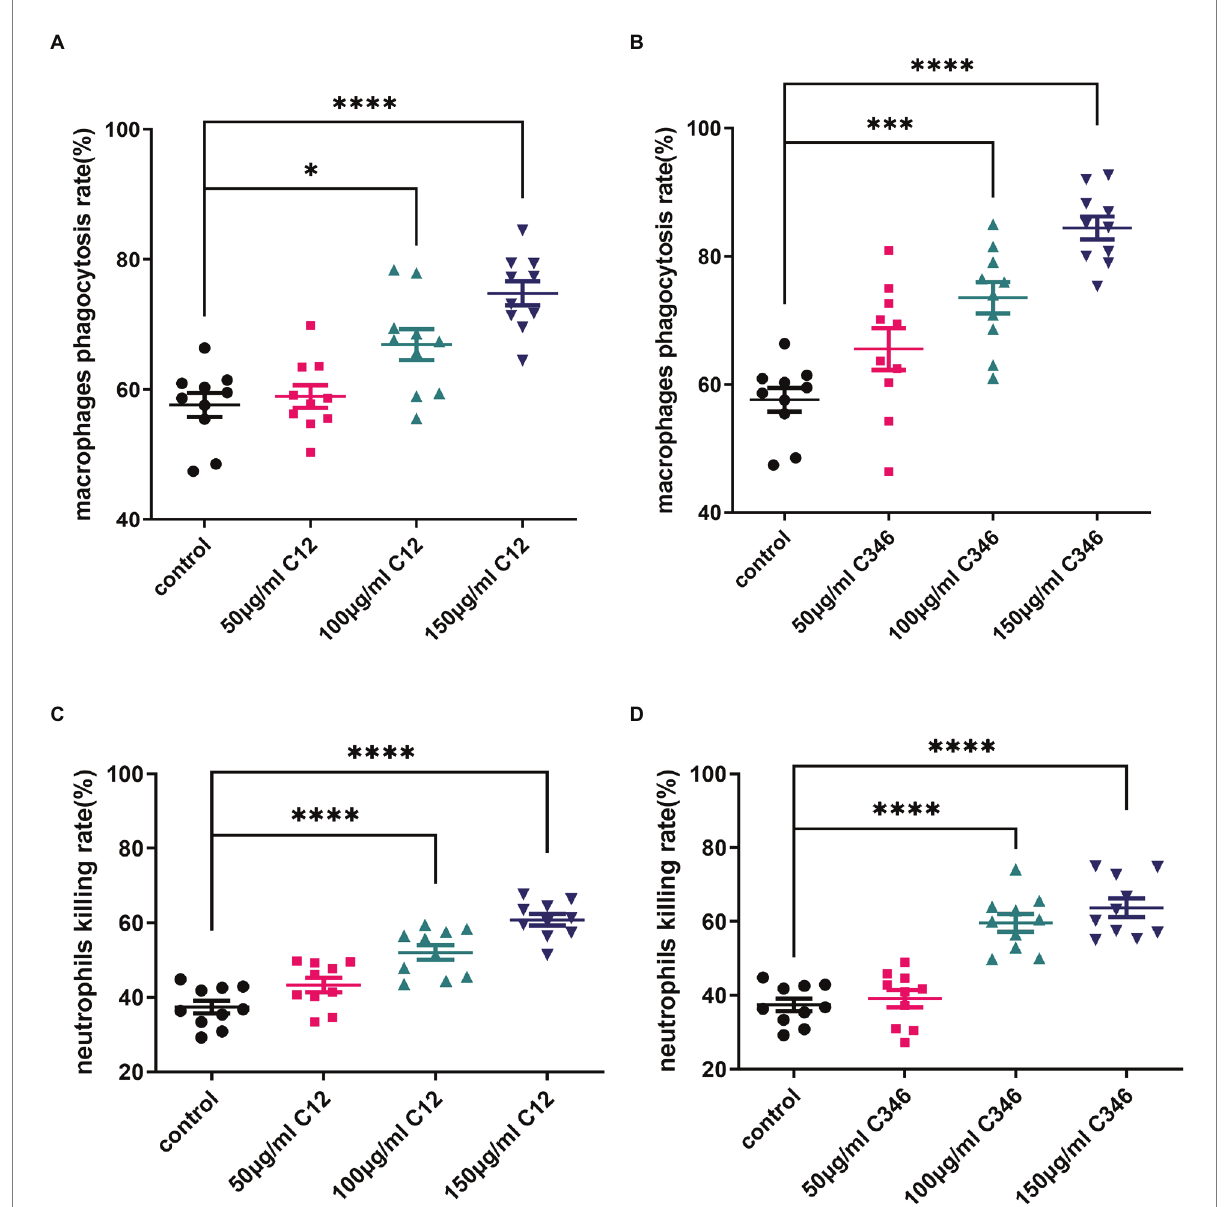
FIGURE 4 The phagocytosis and killing rates of thioglycollate-elicited peritoneal macrophages and neutrophils pretreated with anti-rPmt4p antibodies against C. albicans SC5314. C. albicans SC5314 was incubated with thioglycollate-elicited peritoneal macrophages (MOI = 0.4) in the presence of indicated concentrations of mAb C12 (A) and mAb C346 (B) for 1 h at 37 ° C, followed by washing thrice in PBS. The suspension was plated on YPD agar at 30 ° C for 48 h; the colonies were counted and the phagocytosis rate was calculated. C. albicans SC5314 cells were co-cultured with thioglycollate-elicited peritoneal neutrophils (MOI = 0.05) with the indicated concentrations of mAb C12 (C) and mAb C346 (D) at 37 ° C for 1 h. The suspension was then plated on YPD agar for 48 h. C. albicans colonies were counted and the killing rates were calculated. Data in (A–D) are representative of three independent experiments. * , p < 0.05; *** , p < 0.001; **** , p < 0.0001, one-way